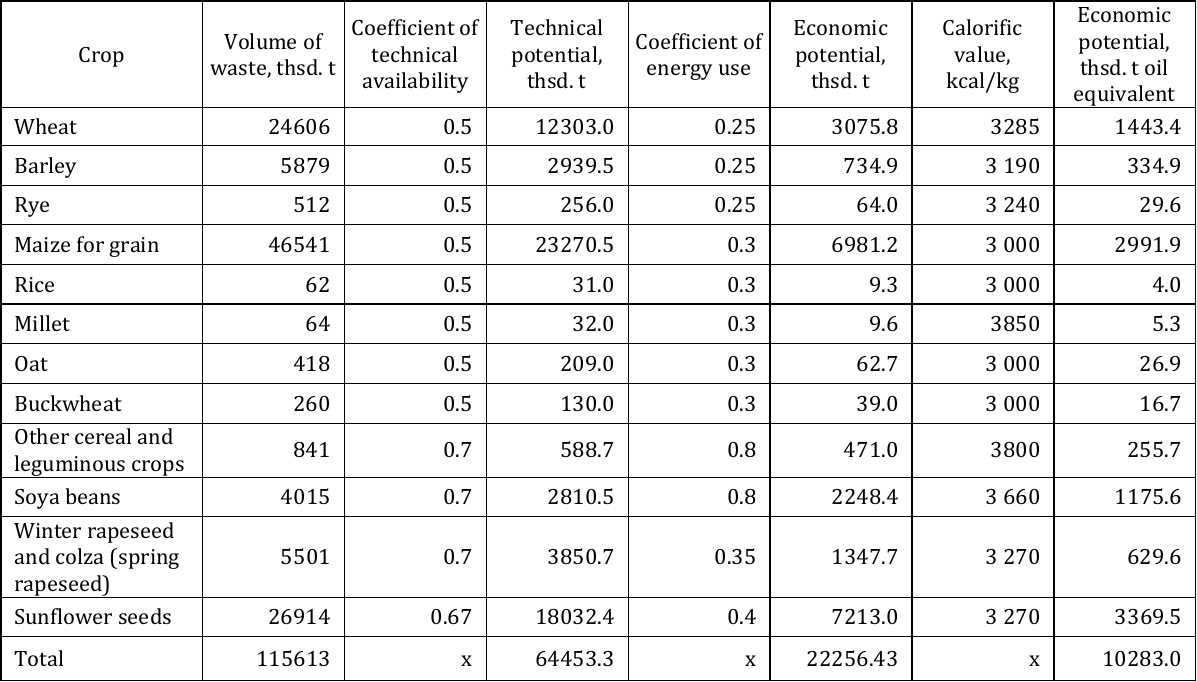
Table 4. Bioenergy potential of primary crop waste in Ukraine, 2018 (Source: calculated by the author according to